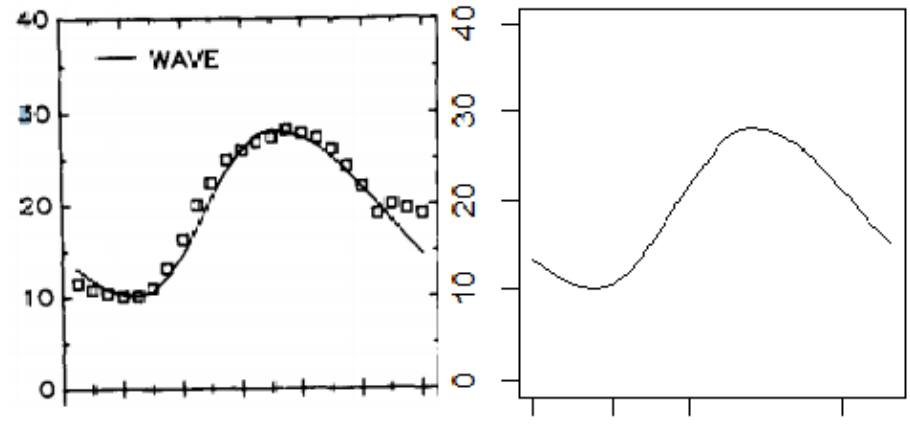
Figure 38. Left: “wave” model [69]. Right: waveform replication of the original article.